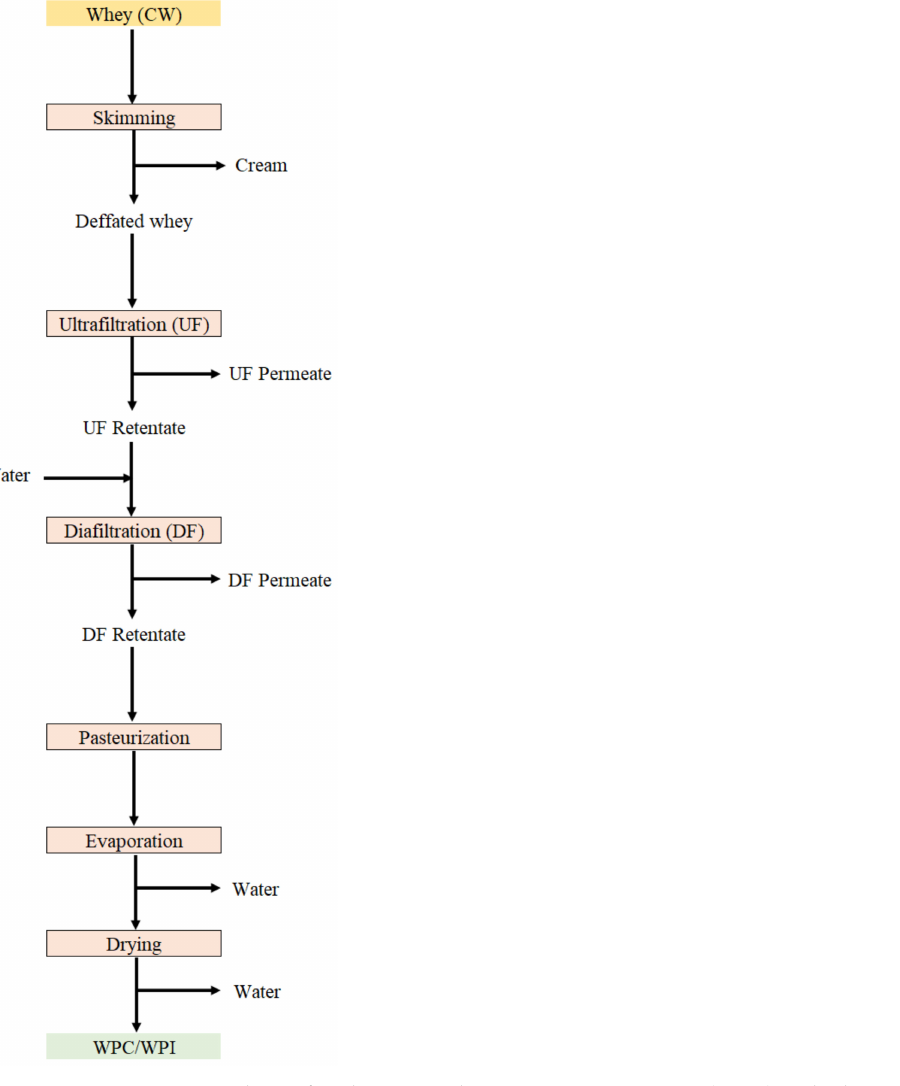
Figure 2. Representative scheme for obtaining whey protein concentrates (WPC) and whey protein isolate